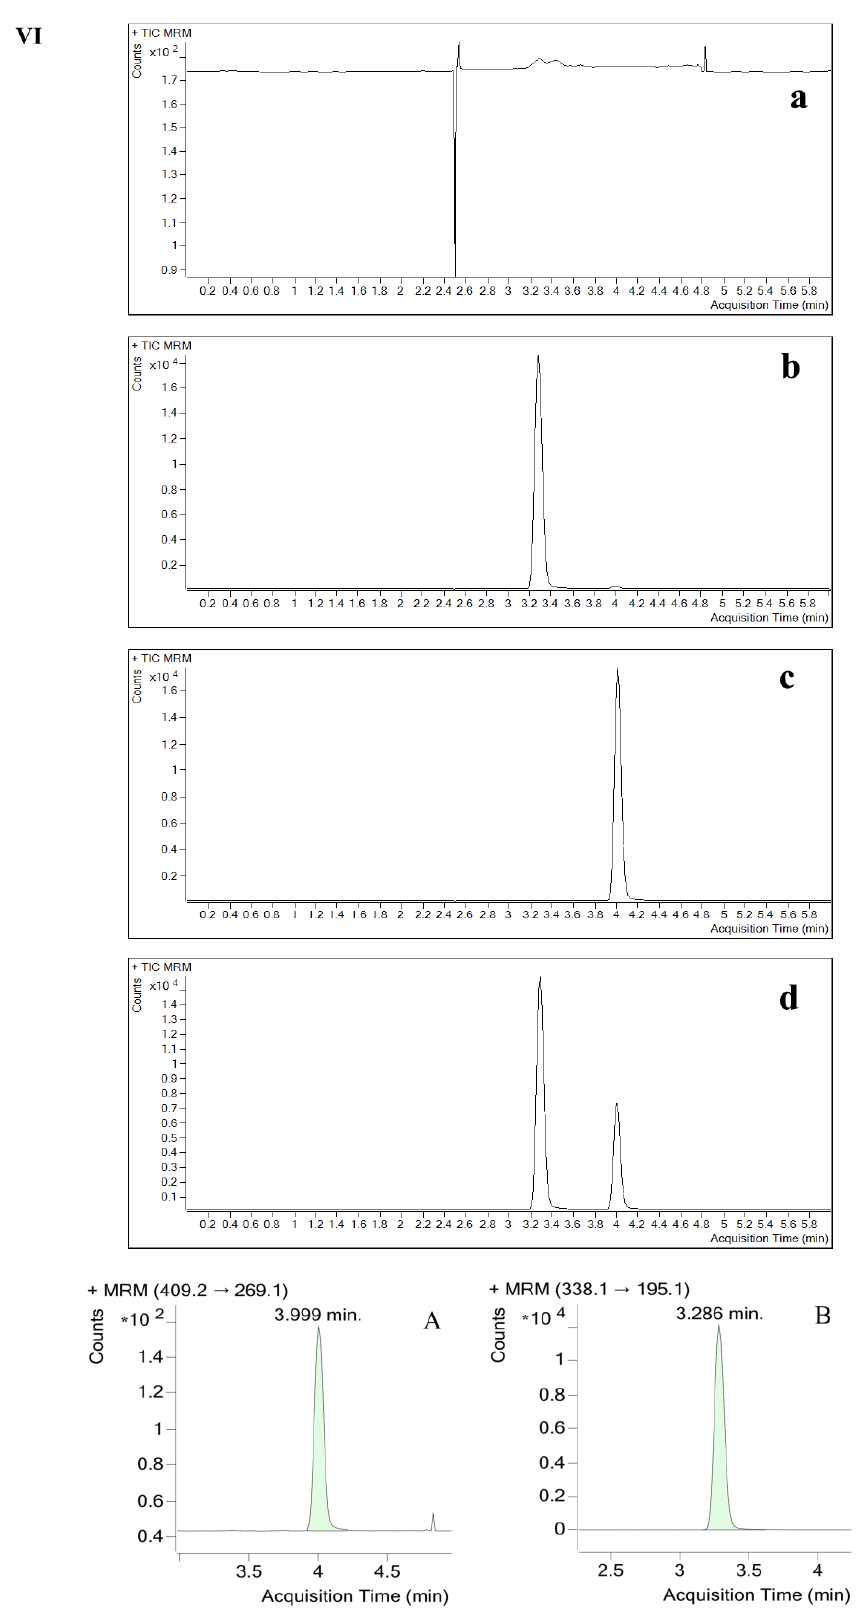
Figure 2. Specificity and selectivity of the method in plasma. ( a ) double blank, ( b ) single blank, ( c ) analyte only and ( d ) analyte and IS (in six different lots). Chromatograms of contezolid ( A ) and linezolid ( B ).